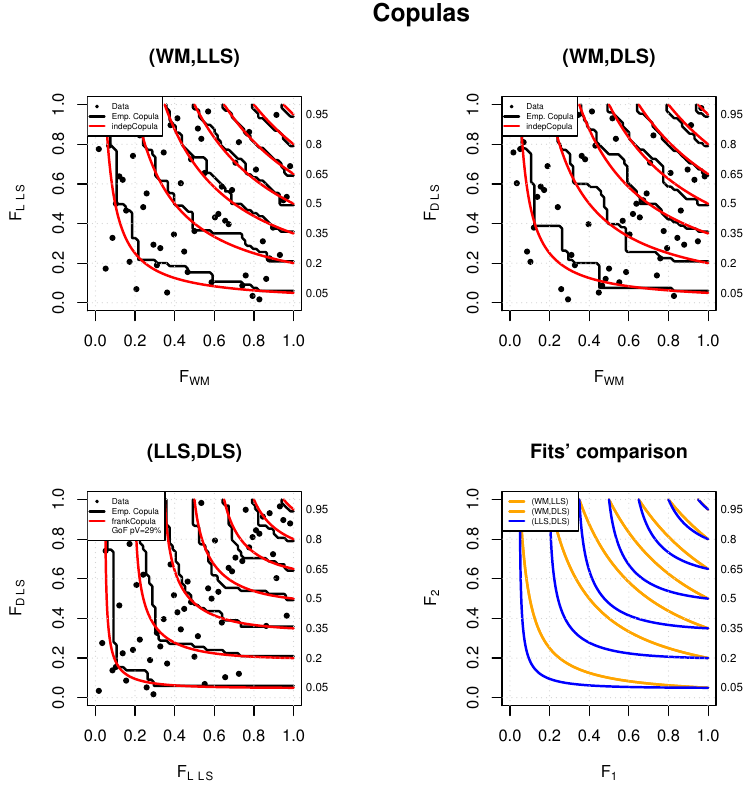
Figure 6. Isolines of the empirical copulas (black lines) of the pairs ( WM, LLS ), ( WM, DLS ), and ( LLS, DLS ) for the ERA-5 dataset, and of the corresponding fitted copulas (red lines). Also shown are the available data (markers). The bottom-right panel shows a comparison between the three fitted